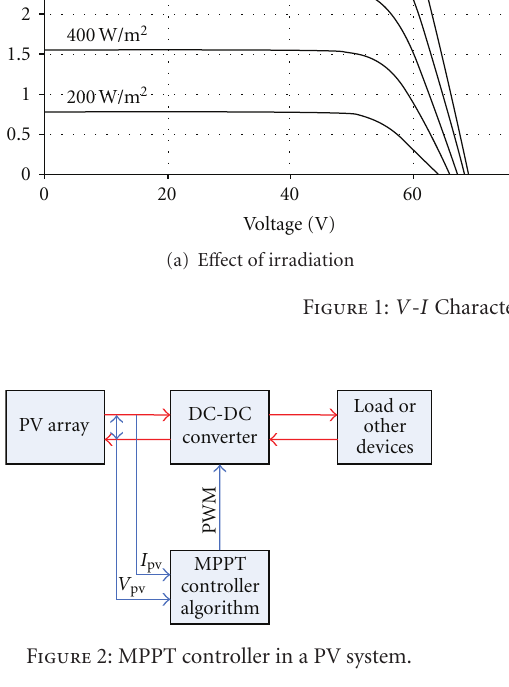
Figure 2: MPPT controller in a PV system.